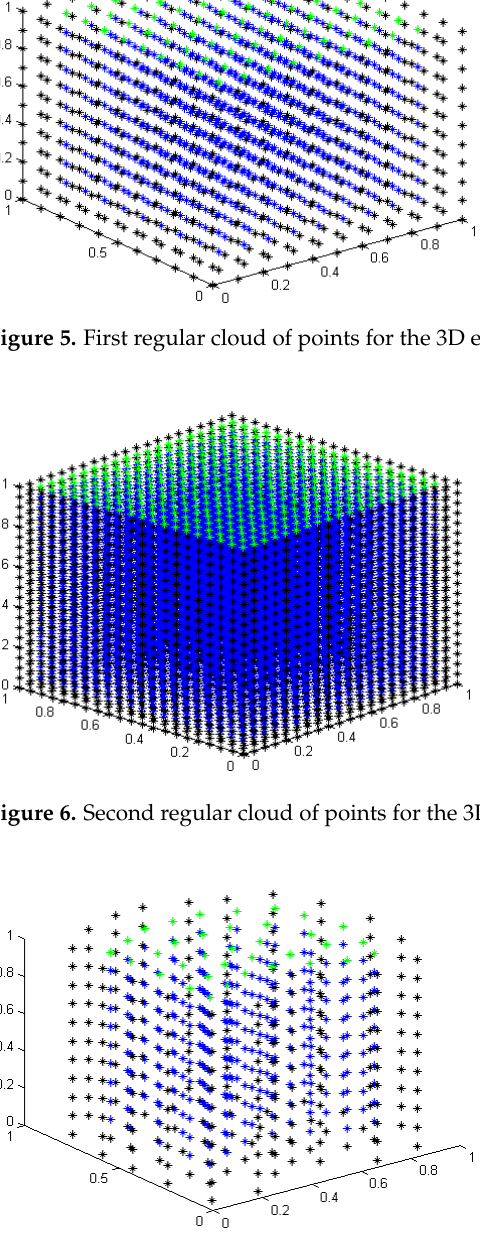
Figure 7. First irregular cloud of points for the 3D examples (Cloud